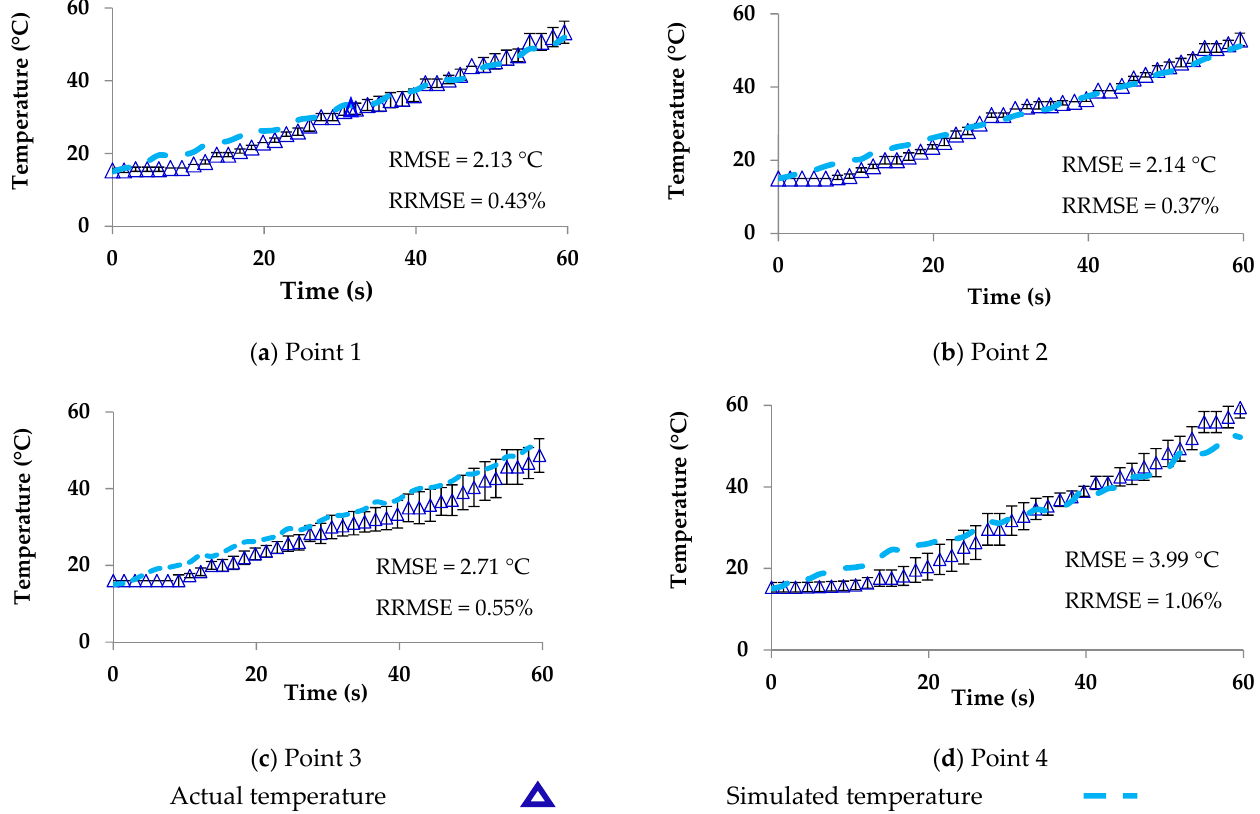
Figure 11. Actual and simulated temperature of ready-to-eat sausage under microwave rotating at points 1–4 from COM- SOL.